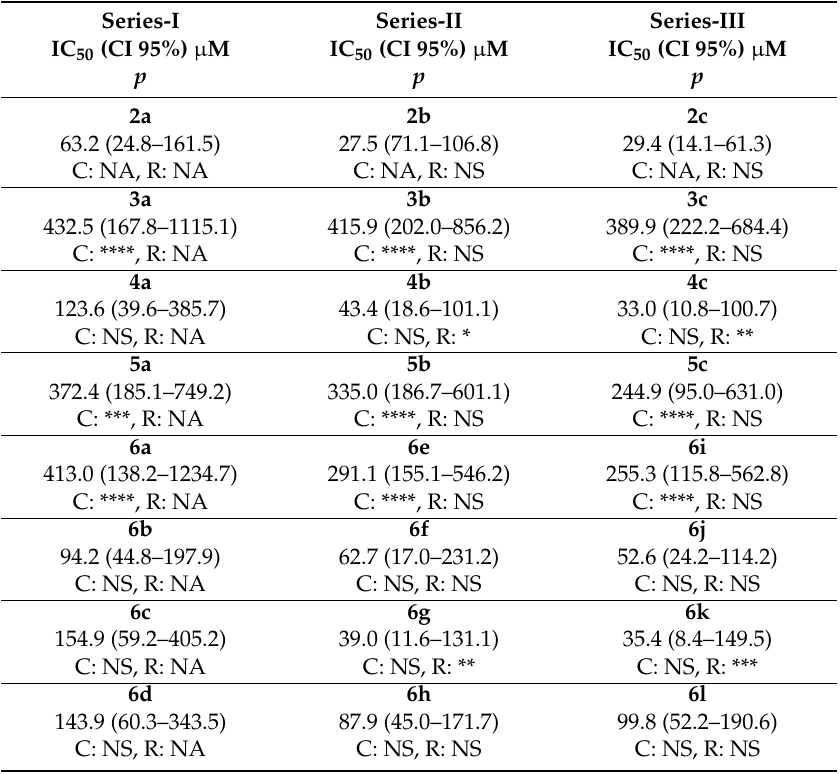
In vitro antiproliferative activities of 1 H -benzo[ f ]indazole-4,9-dione-based derivatives expressed as IC 50 values obtained in MCF-7 cell